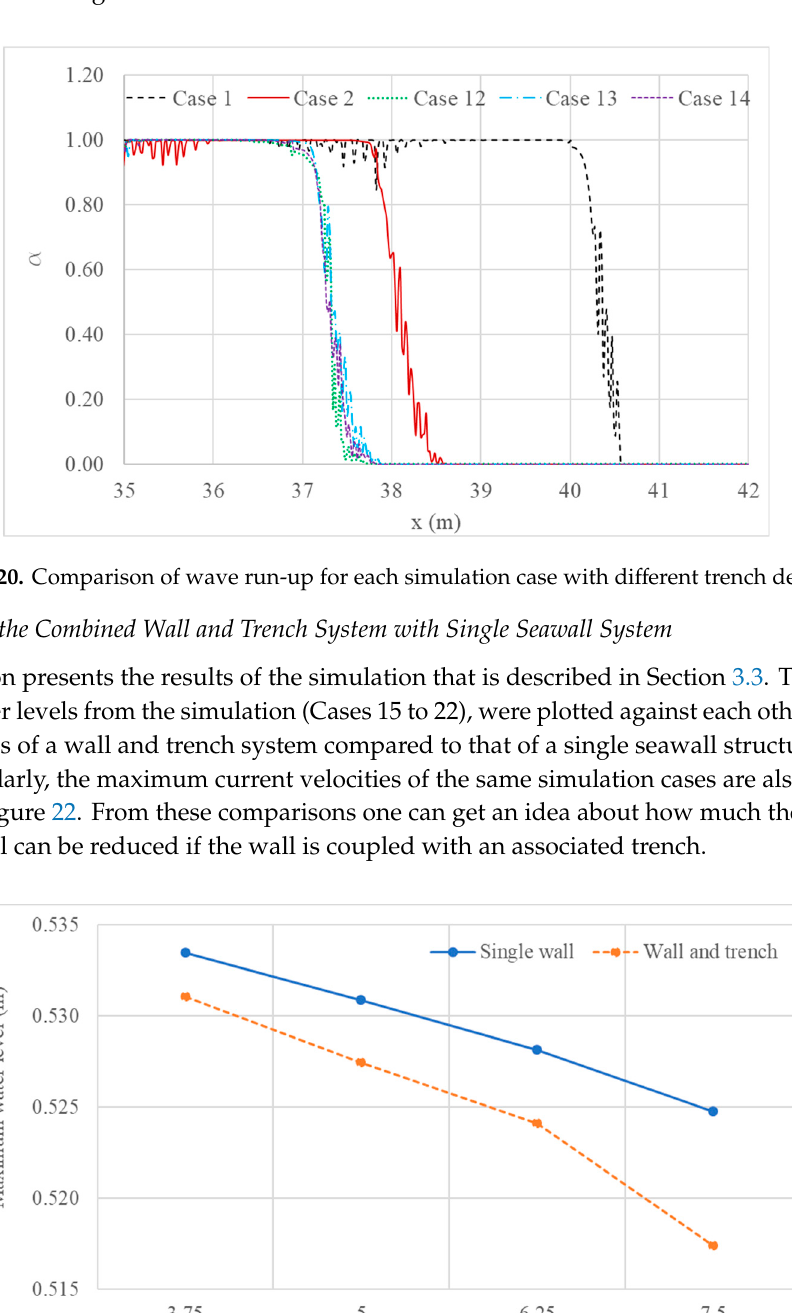
Figure 19. Comparison of wave run-up heights for each simulation case with different wall widths.